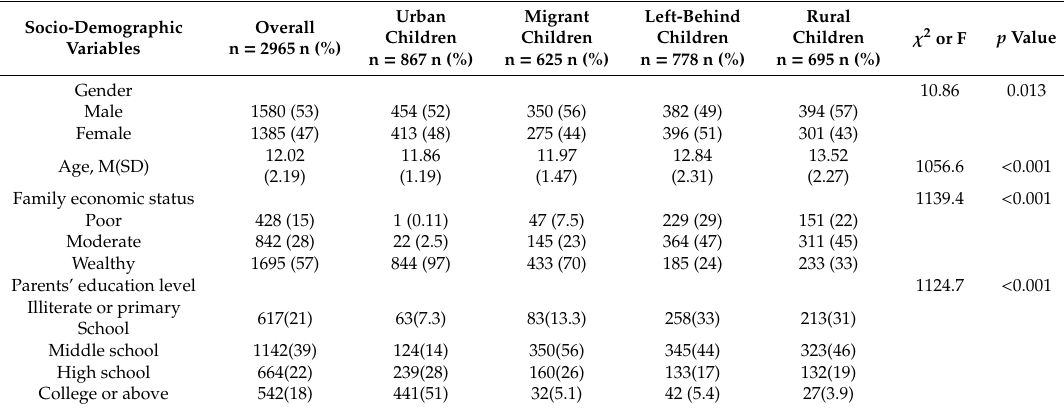
Table 1. The socio-demographic characteristics of